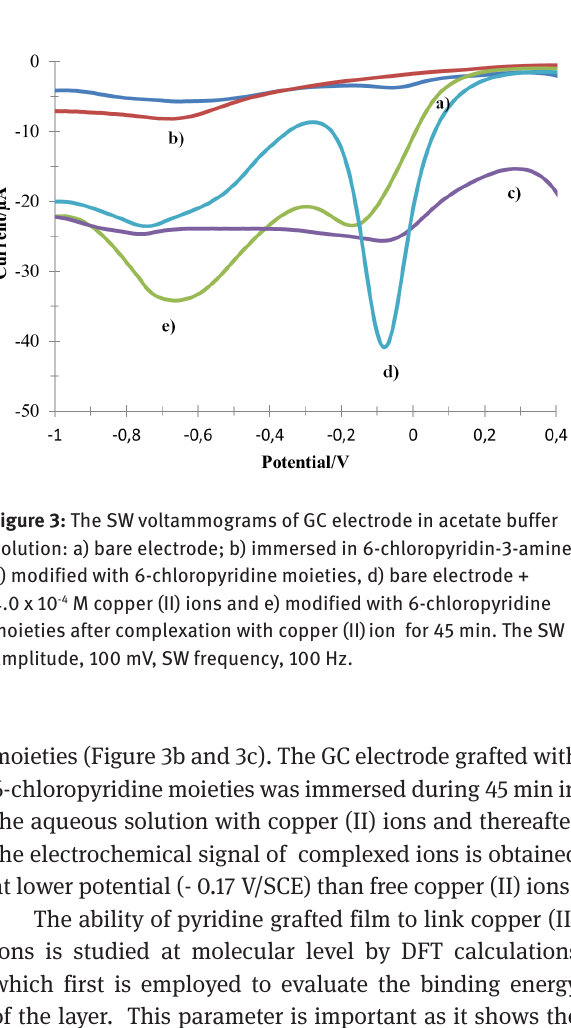
Figure 2: Cyclic voltammograms for the: bare and modified electrode surfaces in the presence of 0.1 M KCl + 2 mM K solution, pH 7, phosphate buffer.